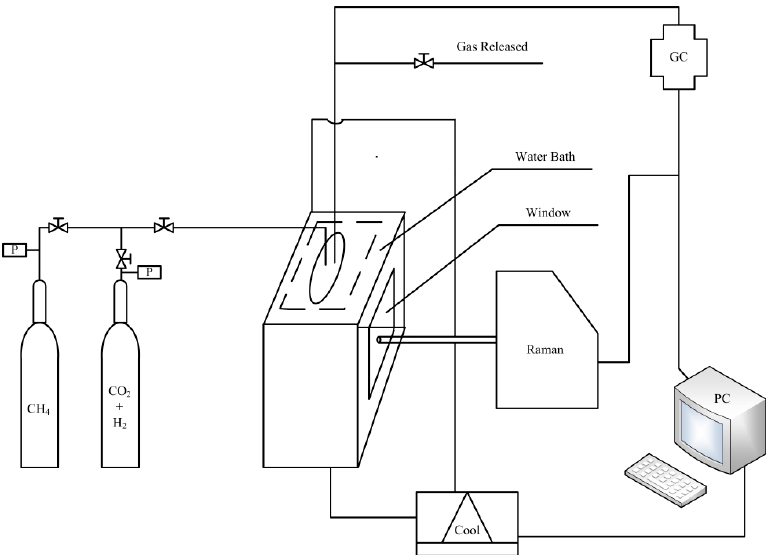
Figure 1. Schematic of experimental apparatus.